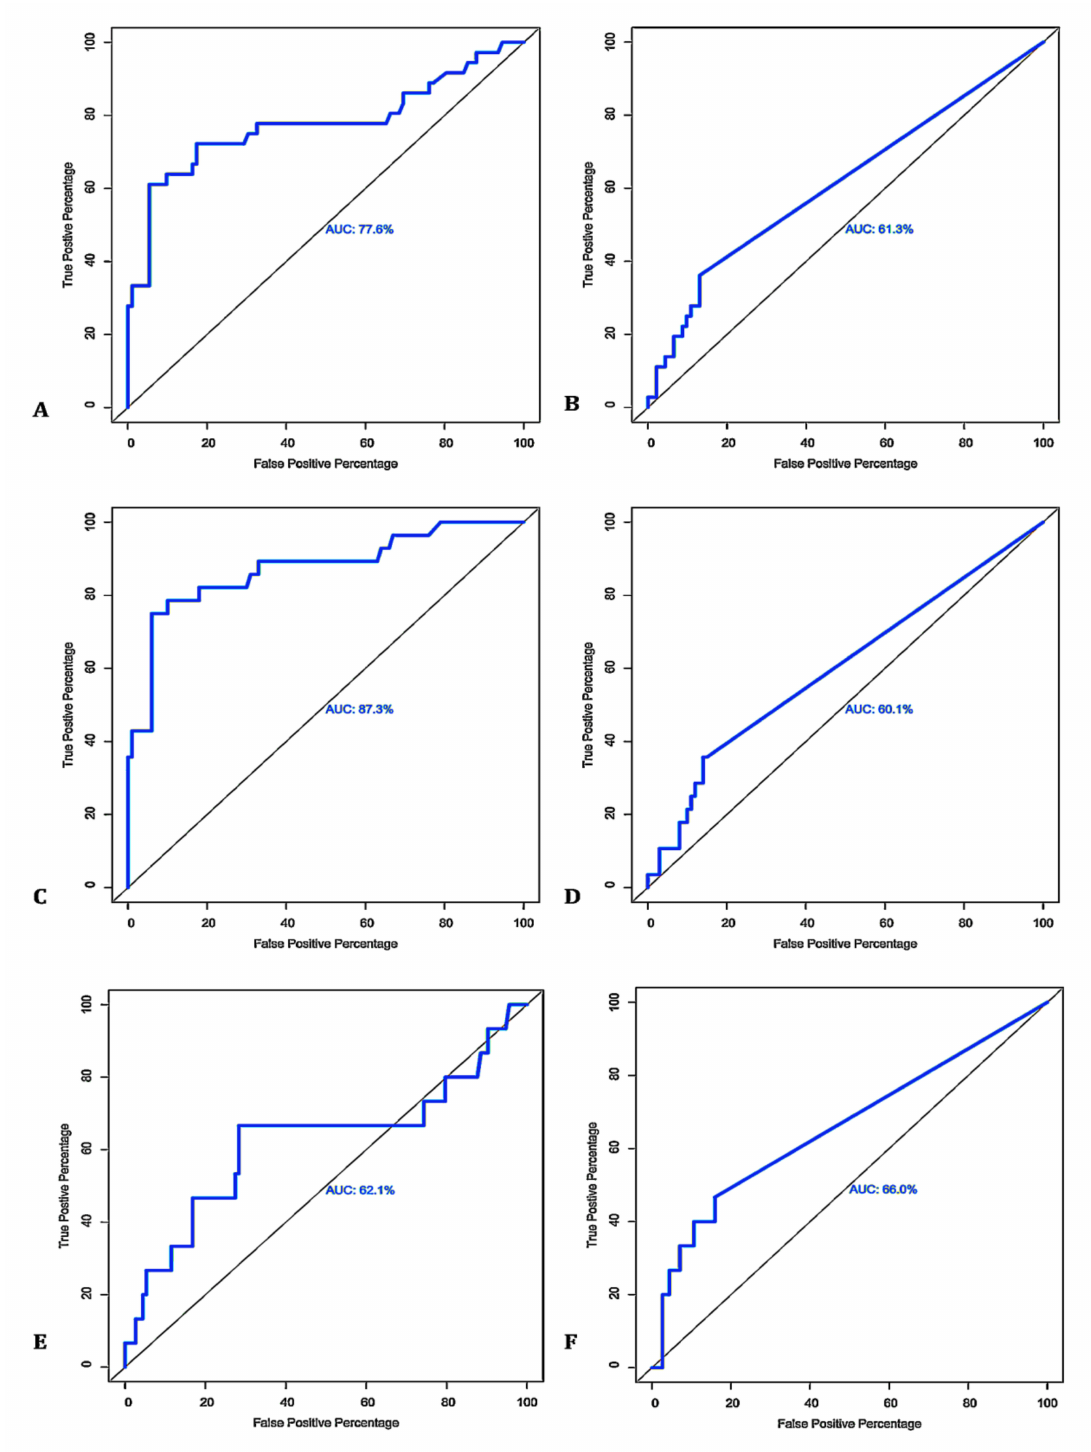
Figure 10. Receiver operating characteristic (ROC) curve analysis and corresponding area under the curve (AUC) analysis of MELISA ( A , C , E ) and MqPCR ( B , D , F ) datasets. The sensitivity and specificity of the MELISA and MqPCR tests in the detection of MAP in 128 MIF milk samples were evaluated based on three di ff erent gold standards of SELISA and FPCR ( A , B ), SELISA ( C , D ), and FPCR ( E , F